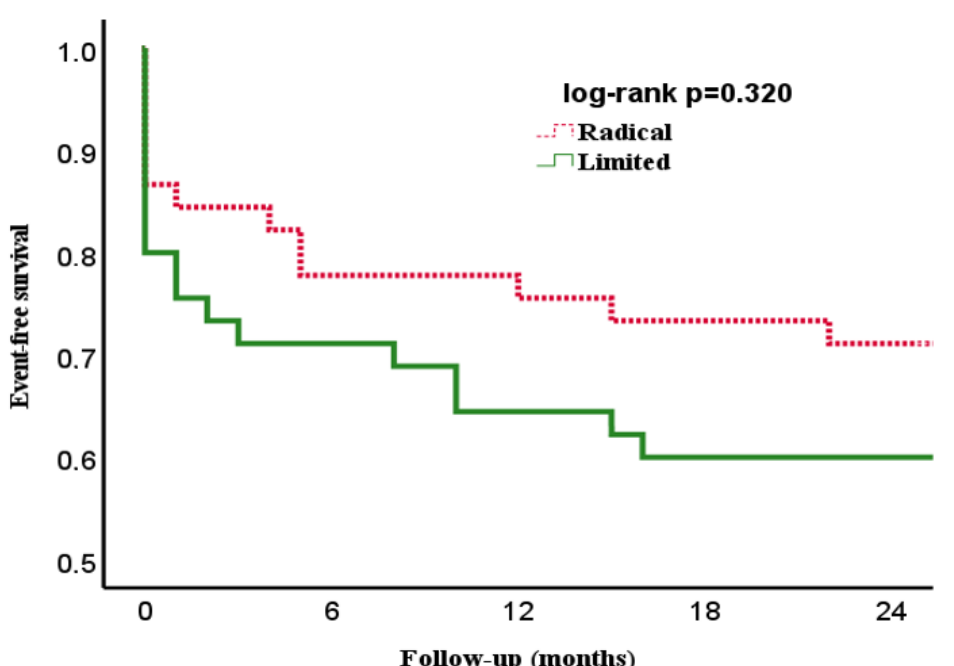
Figure 2. Kaplan–Meier curve showing event-free survival of patients with infective endocarditis of the native mitral valve undergoing surgical therapy by limited-resection (limited) and radical-resection (radical) strategy.